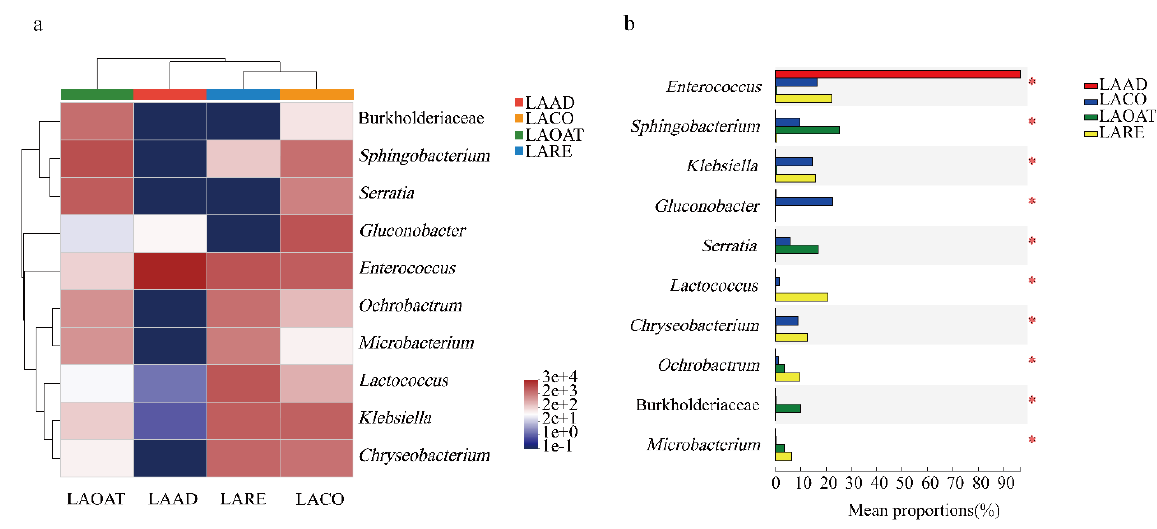
Figure 4. Comparison of the top ten most abundant genera in the gut of C. suppressalis raised on four different diet regimes. ( a ) Heatmap of the relative abundance of the top ten shared genera. The colors indicate relative abundance ranging from blue grey (lower abundance) to white and red grey (higher abundance). The color scale represents the normalized values of relative abundances by log10. ( b ) Relative abundances of the top ten genera that showed statistical differences among sam-